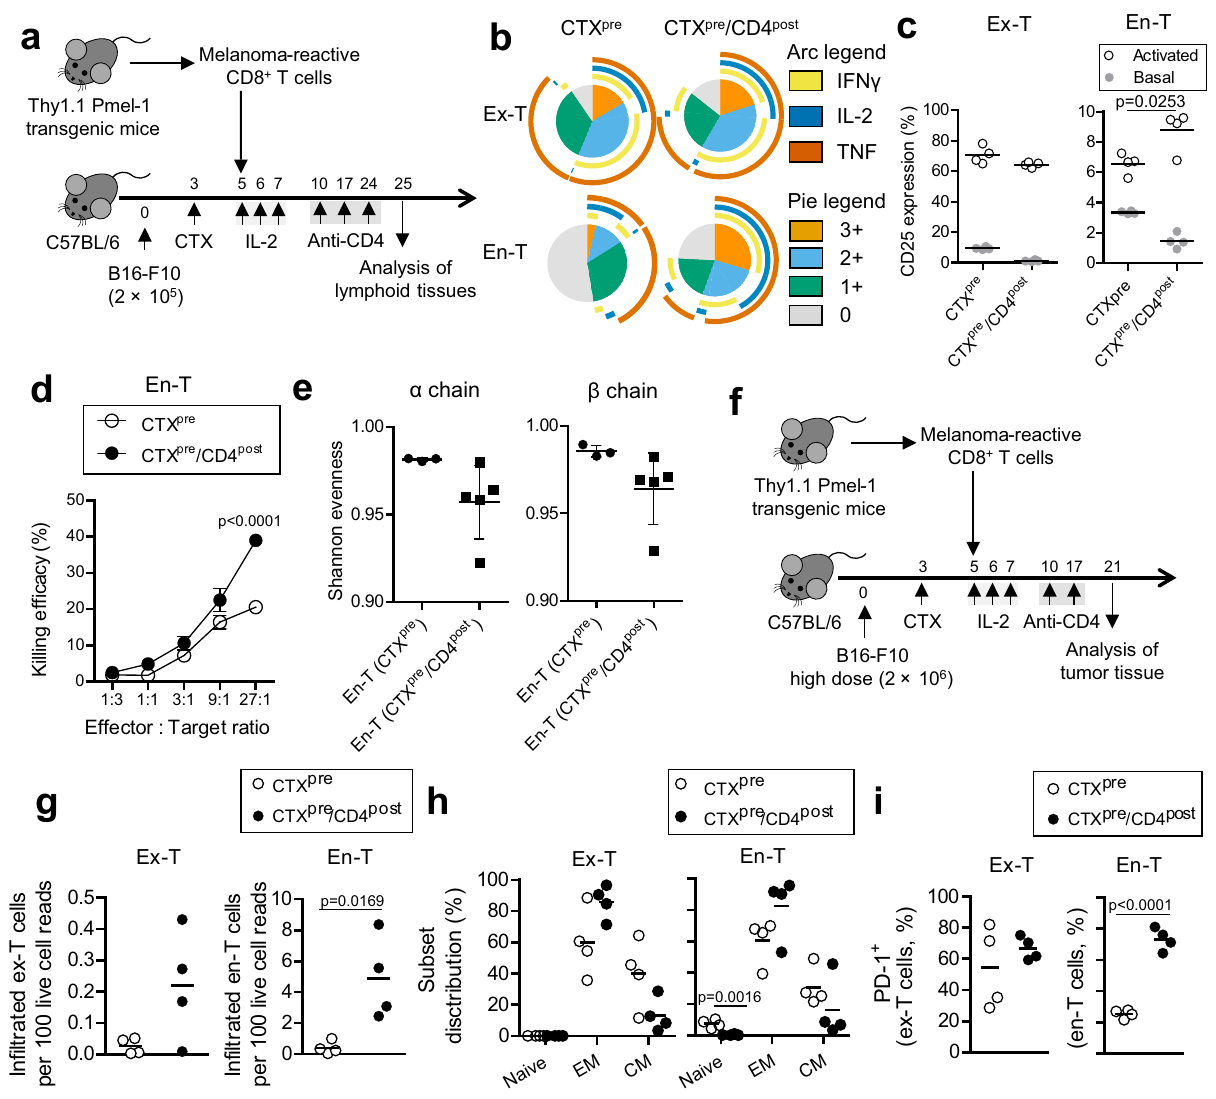
Fig. 3 Anti-CD4 post conditioning increases tumor reactivity of endogenous CD8 + T cells. a Schematic of the experiment. Injected cell number: B16-F10, 2 × 10 5 /mouse; ex vivo-primed Thy1.1 + Pmel-1 CD8 + T (ex-T) cells, 2 × 10 6 /mouse. b Analysis of polyfunctionality. Cells were stimulated and analyzed for cytokine expression as in Supplementary Fig. 5a, b. SPICE v6.0 was used to draw the pie chart. Arc length indicates the proportion of cells expressing the corresponding marker. Pie area indicates the proportion of cells expressing the given number of functional markers. n = 5 mice per group. c CD25 expression was analyzed in lymphocytes incubated with (activated) or without (basal) B16-F10 for 16 h. d The killing ef fi ciency of endogenous CD8 + (en-T) cells against B16-F10 was evaluated. Cells from four mice of each group were pooled and assayed in biological triplicates. Error bars indicate means± SEM. Two-way ANOVA with Bonferroni post hoc test was used to determine statistical signi fi cance. e Shannon evenness (normalized Shannon – Wiener index) of TCR clonotype analysis. TCR α -chain (left) and TCR β -chain (right) of en-T cells were analyzed. CTX pre , n = 3 mice; CTX pre /CD4 post , n = 5 mice. Error bars indicate means ± SD. d , e En-T cells isolated as in Supplementary Fig. 3e, f were used. f – i Characterization of tumor-in fi ltrating CD8 + T cells. f Schematic of the tumor tissue experiments. Injected cell number: B16-F10, 2 × 10 6 /mouse; ex-T cells, 2 × 10 6 /mouse. g The count of ex-T and en-T cells among 100 live cells from tumor tissues were calculated using fl ow cytometry data. h The proportion of naive (CD62L + CD44 − ), EM (effector memory; CD62L − CD44 + ), and CM (central memory; CD62L + CD44 + ) subsets were calculated. i The frequency of cells expressing PD-1 in ex-T and en-T cells are shown. c , g – i n = 4 mice per group. c , e , g – i Each symbol indicates the calculated value of an individual mouse. Horizontal bars indicate means. c , g – i Two- tailed unpaired Student ’ s t -test. CD4 post , anti-CD4 post conditioning; CTX pre , cyclophosphamide preconditioning. Source data are provided as a Source Data fi